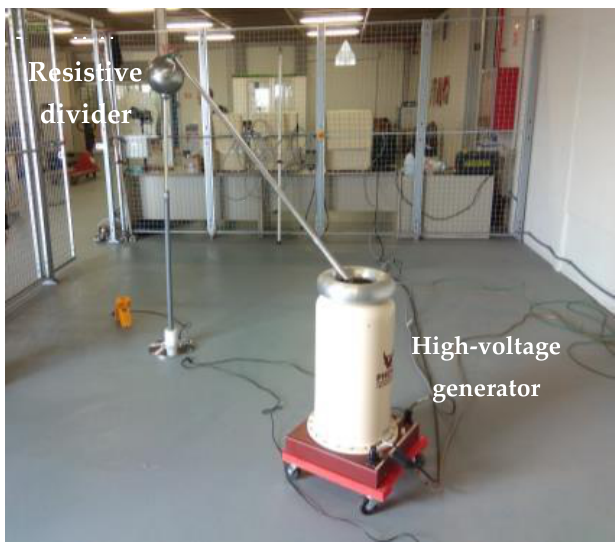
Figure 4. High-voltage resistive divider analyzed in this work and AC generator.